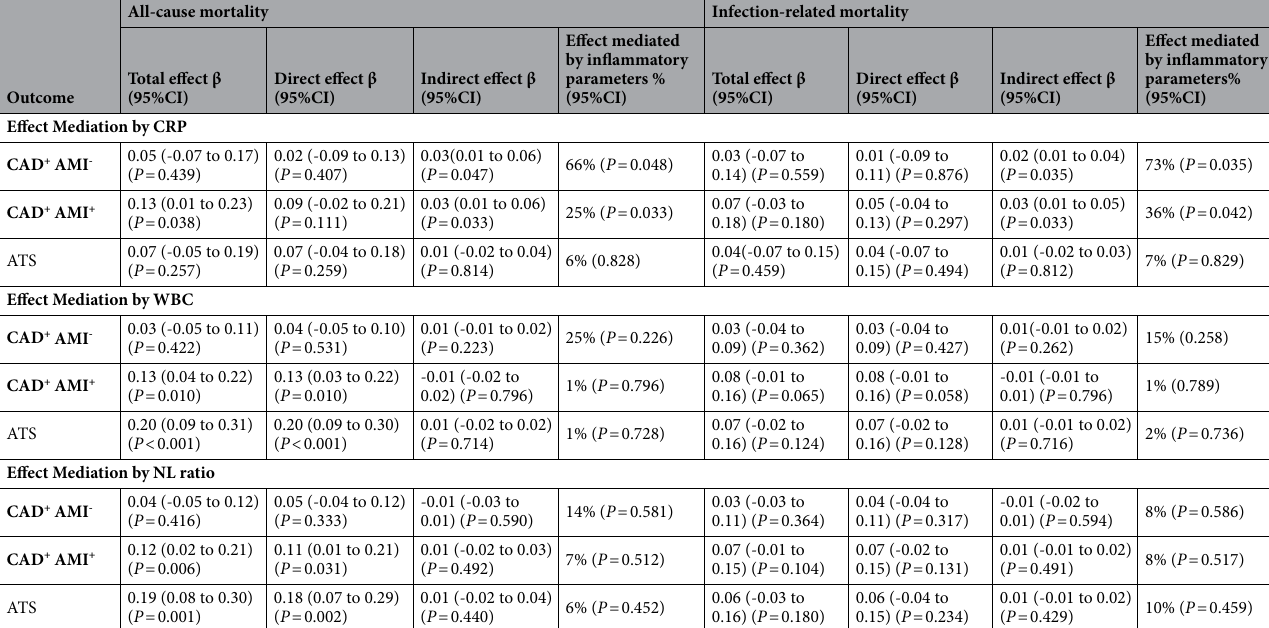
Table 4. Assessment of mediation of the effect of CAD and ATS on mortality by inflammatory parameters (adjusted analysis). ATS: Atherothrombotic stroke, CAD + AMI + : Coronary artery disease with history of Acute myocardial infarction; CAD + AMI-: Coronary artery disease without history of Acute myocardial infarction, B: Regression co-efficient, SE: Standard error. # Adjusted for age, gender, body mass index (BMI), diabetes mellitus (DM), hypertension (HTN), cancer, chronic kidney disease (stage 3–5), asthma, chronic obstructive pulmonary disease (COPD), liver cirrhosis, transplant status, metformin use, statin use, and calcium channel blocker use. & Additionally adjusted for ATS. $ Additionally adjusted for